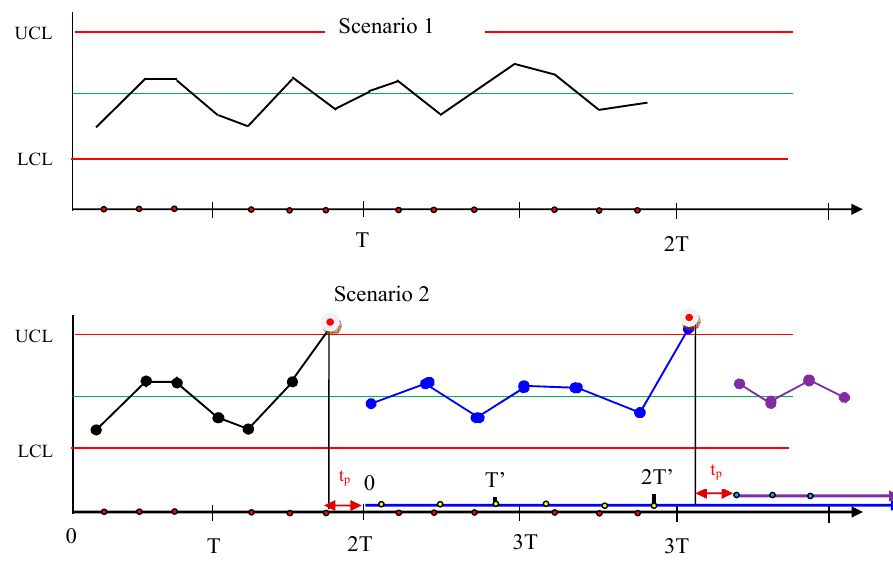
Figure 3. The two scenarios of quality control and evolution of maintenance.